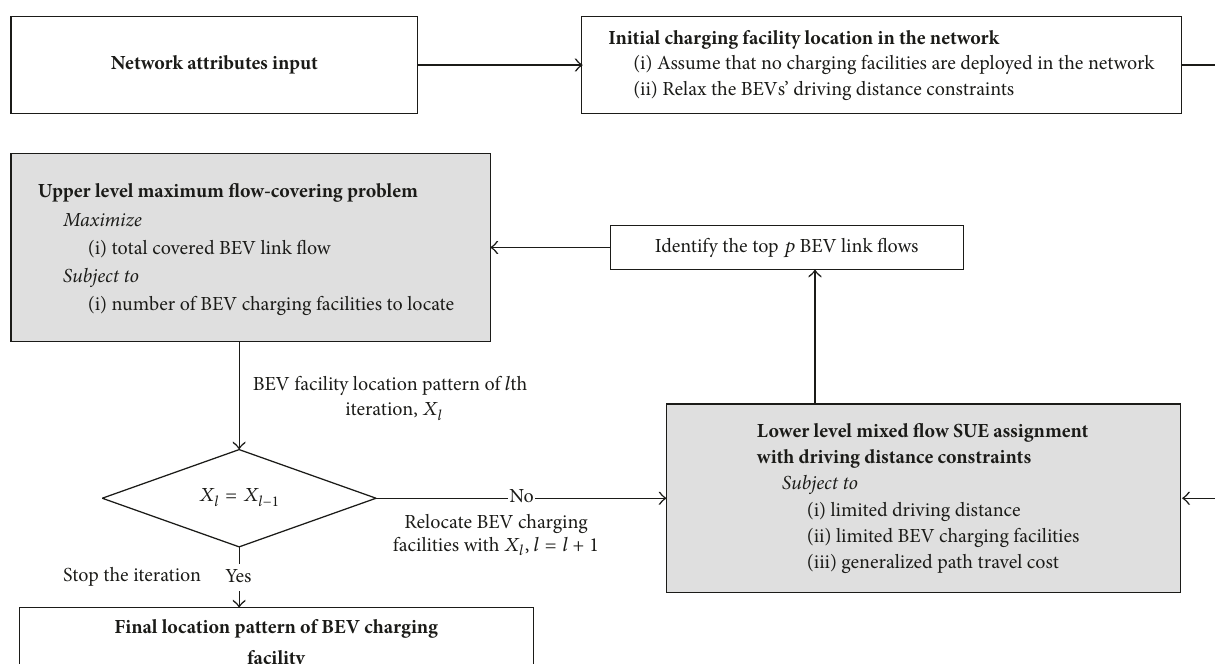
Figure 2: Framework of the bilevel proposed method for the equilibrium-optimization-based BEV charging facility location problem.